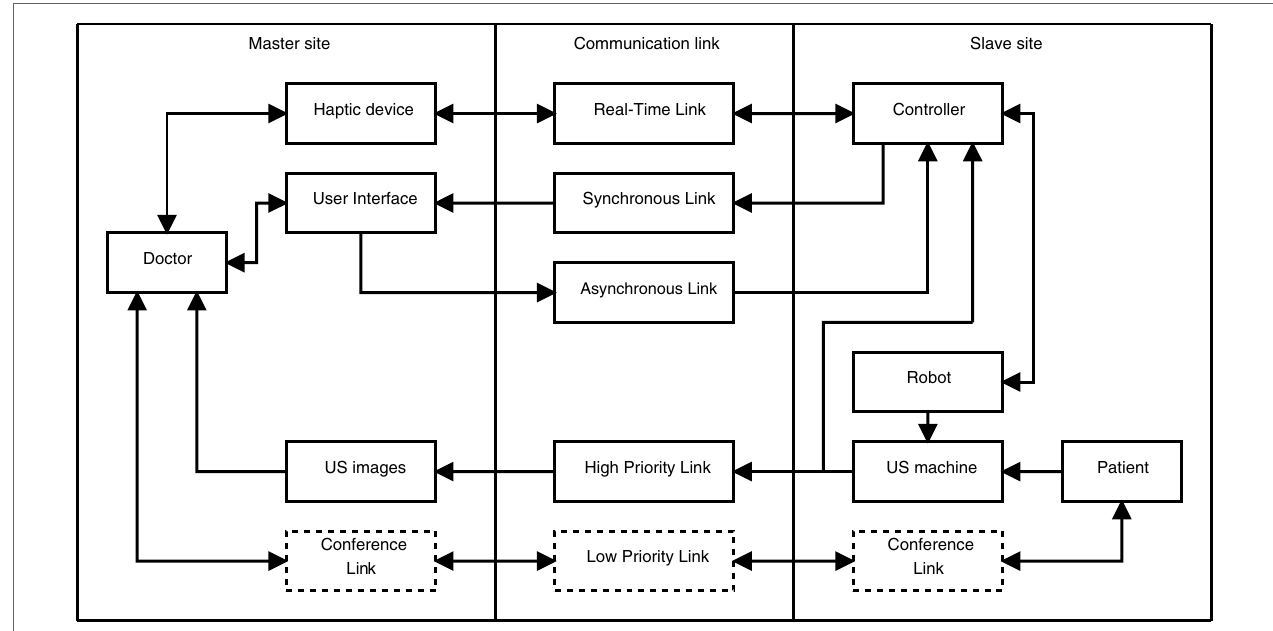
FigUre 1 | system overview showing the three main parts of the system and the flow of information denoted by arrows. The slave site consists of the patient, a robot holding an ultrasound probe and a controller for controlling the robot. At the master site, the physician is controlling the robot using a haptic device while viewing the ultrasound images acquired at the slave site. The communication links are classified based on their required